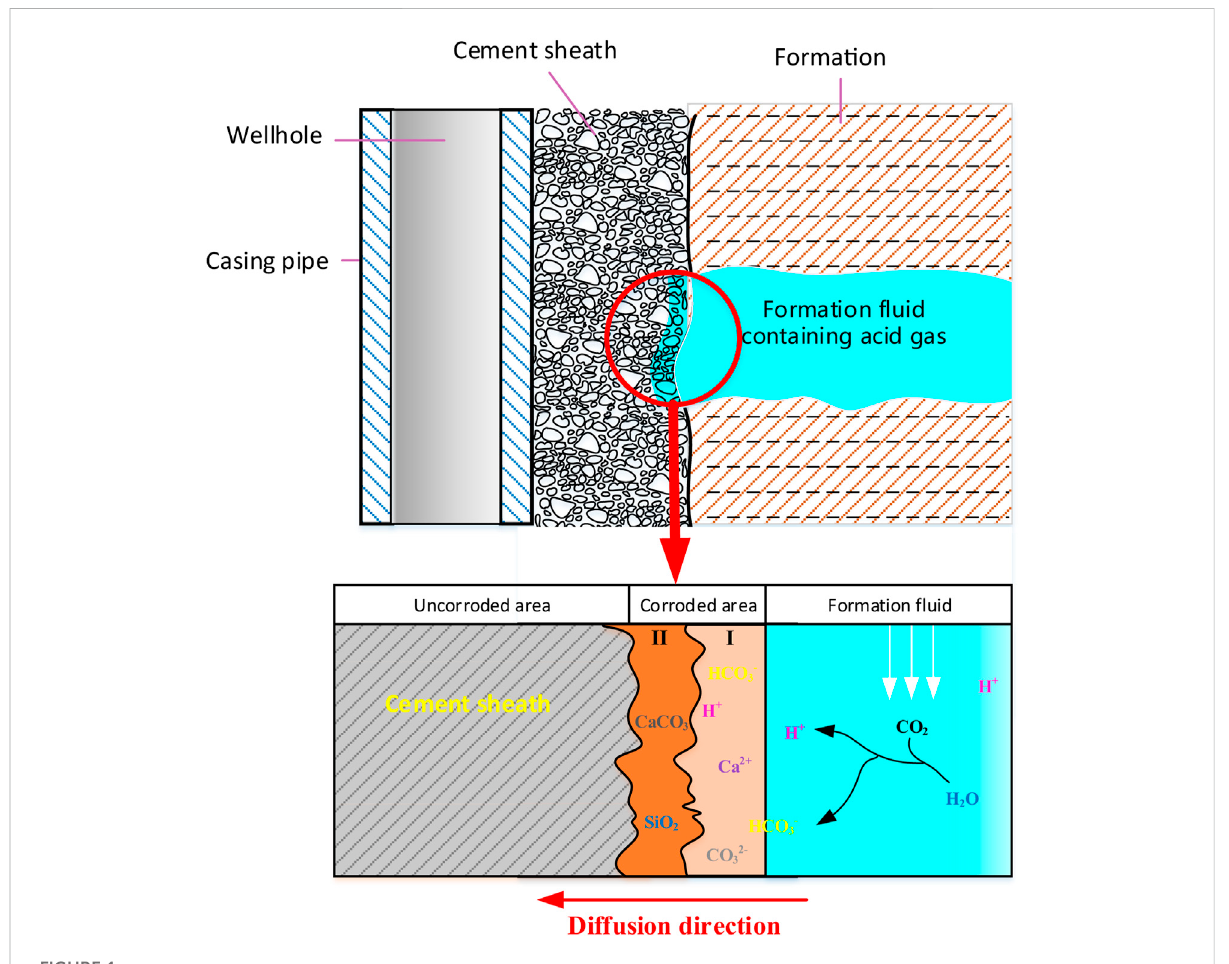
Corrosion process of cement sheath during well